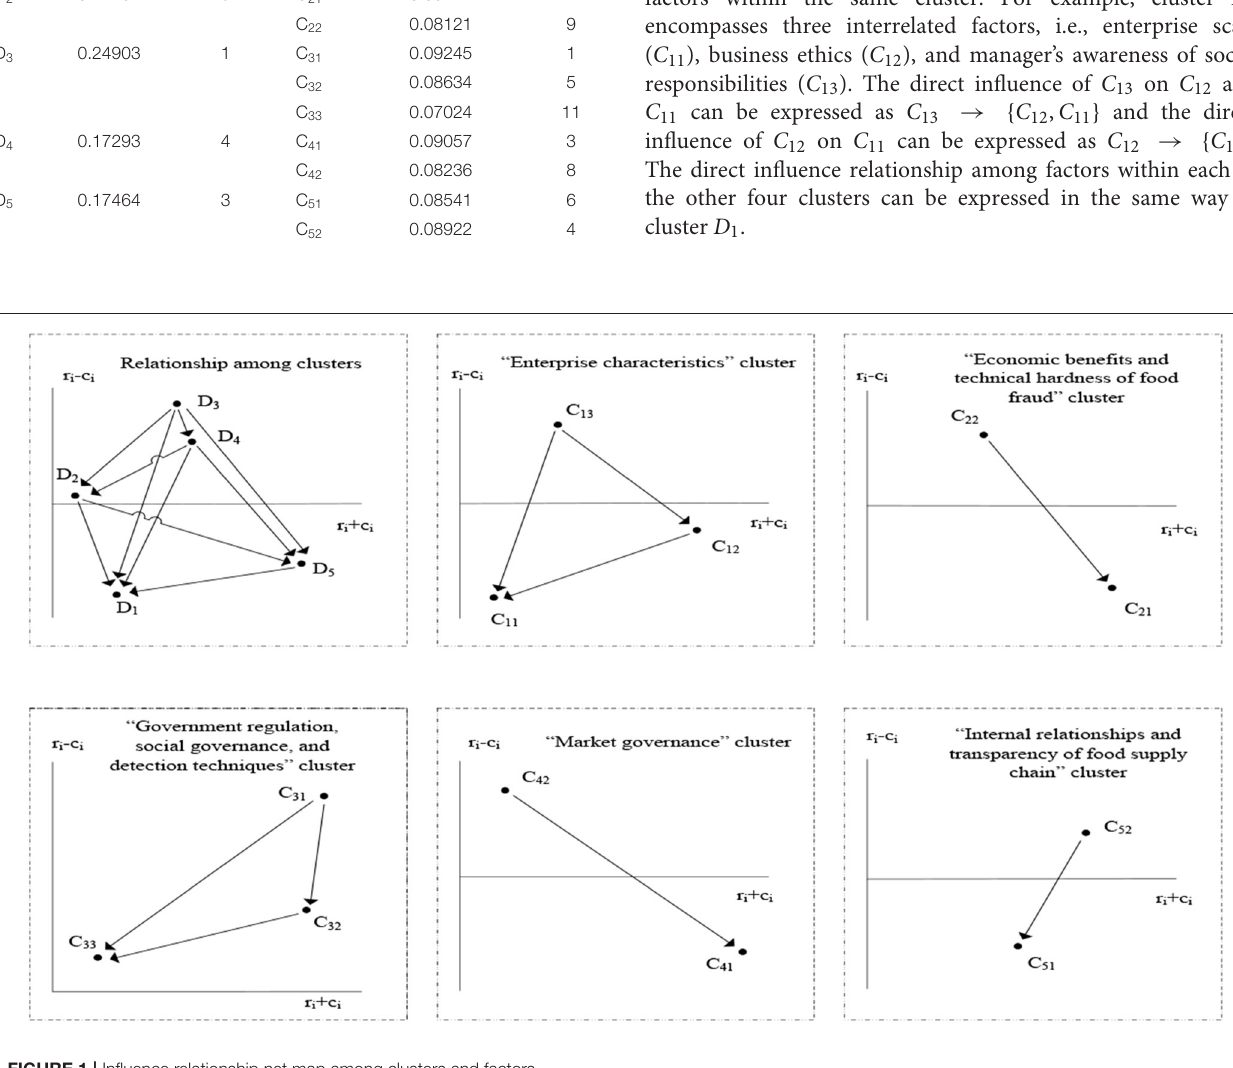
Frontiers in Public Health |